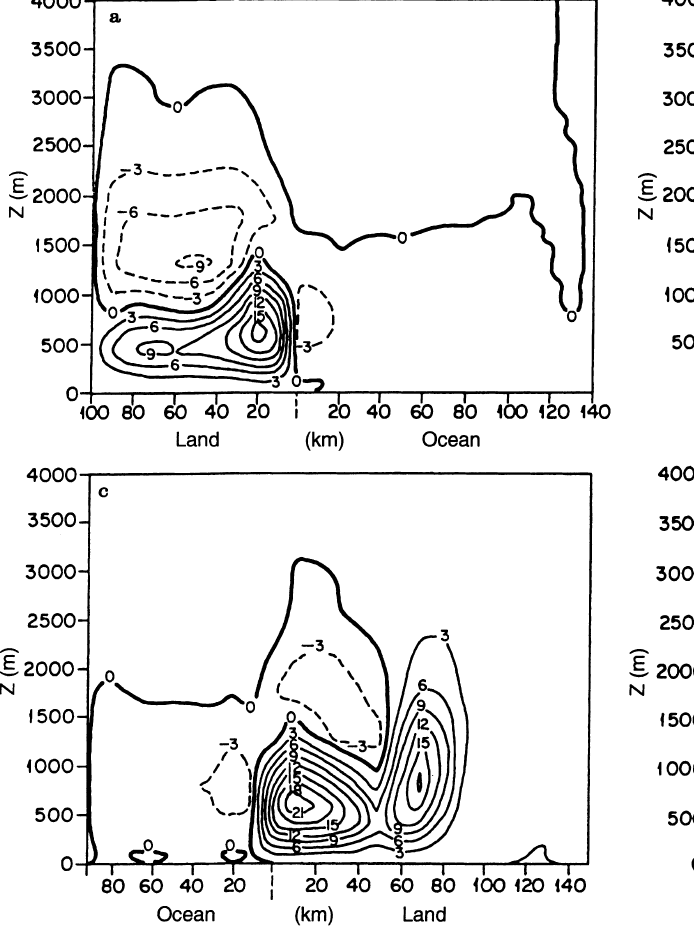
Fig. 8a–d. Cross section of the simulated vertical velocity at 15:00 LT: a EW variation of w along a line parallel to AB (Fig. 1) situated 5 km northward from the EW coastline for OND; b same as a , except for